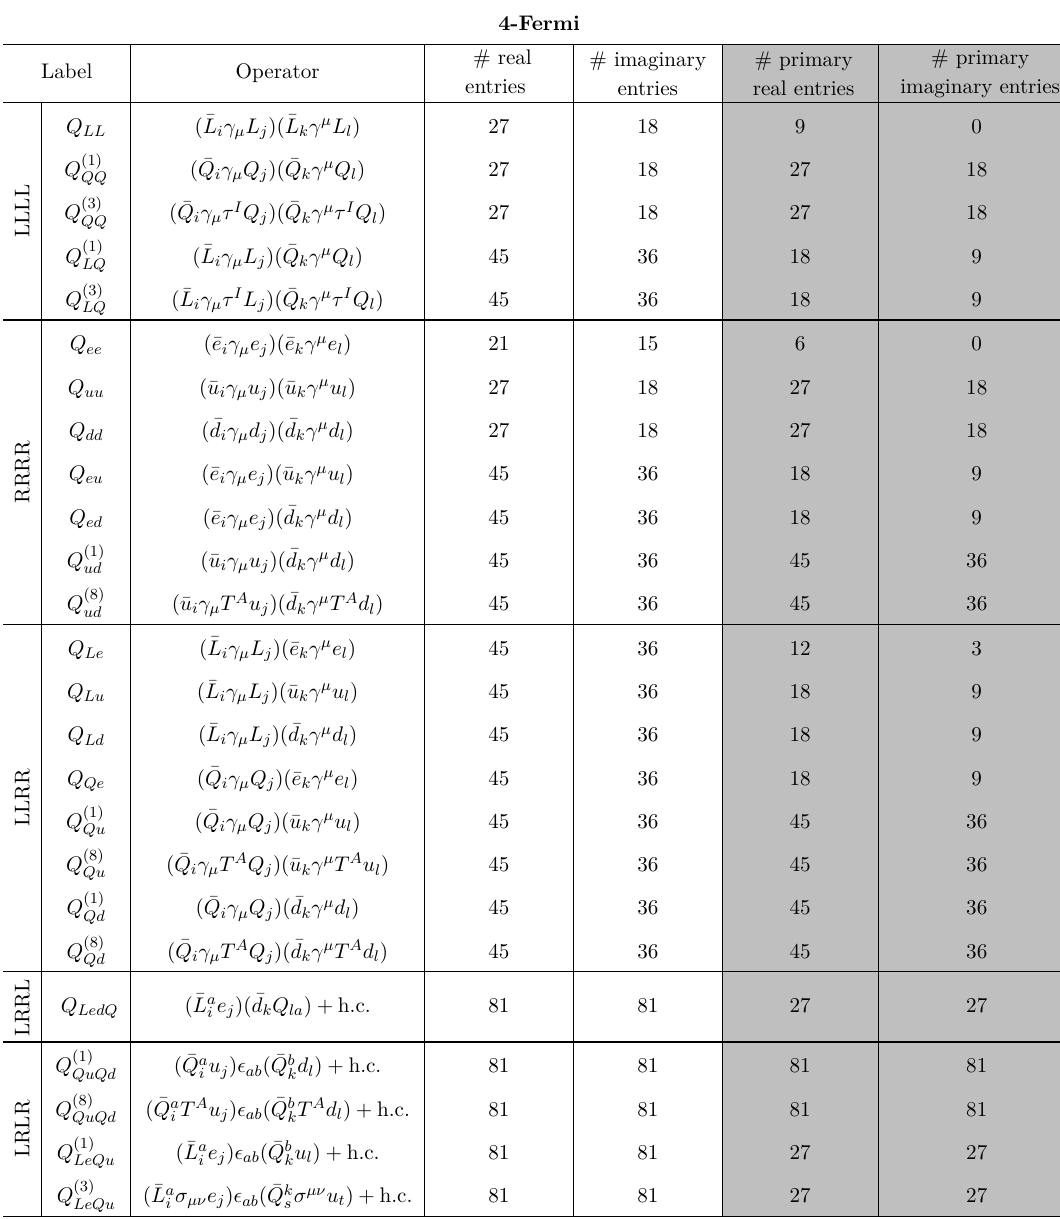
Table 8 . The list of dimension-6 4-Fermi operators of SMEFT, as given in ref. [37], together with the number of real and imaginary entries they each contain, as well as the number of primary parameters (highlighted in gray, see the text for more details). When + h.c. is specified, the hermitian conjugate of the operator must be included, too. We indicate with i, j, k, l the flavor indices and with a, b indices in the fundamental of SU(2) L . T A , A = 1 , . . . , 8 are the generators of the gauge SU(3) c , while τ I = σ I , I = 1 , 2 , 3 are the generators of SU(2) L , with σ I the Pauli 2